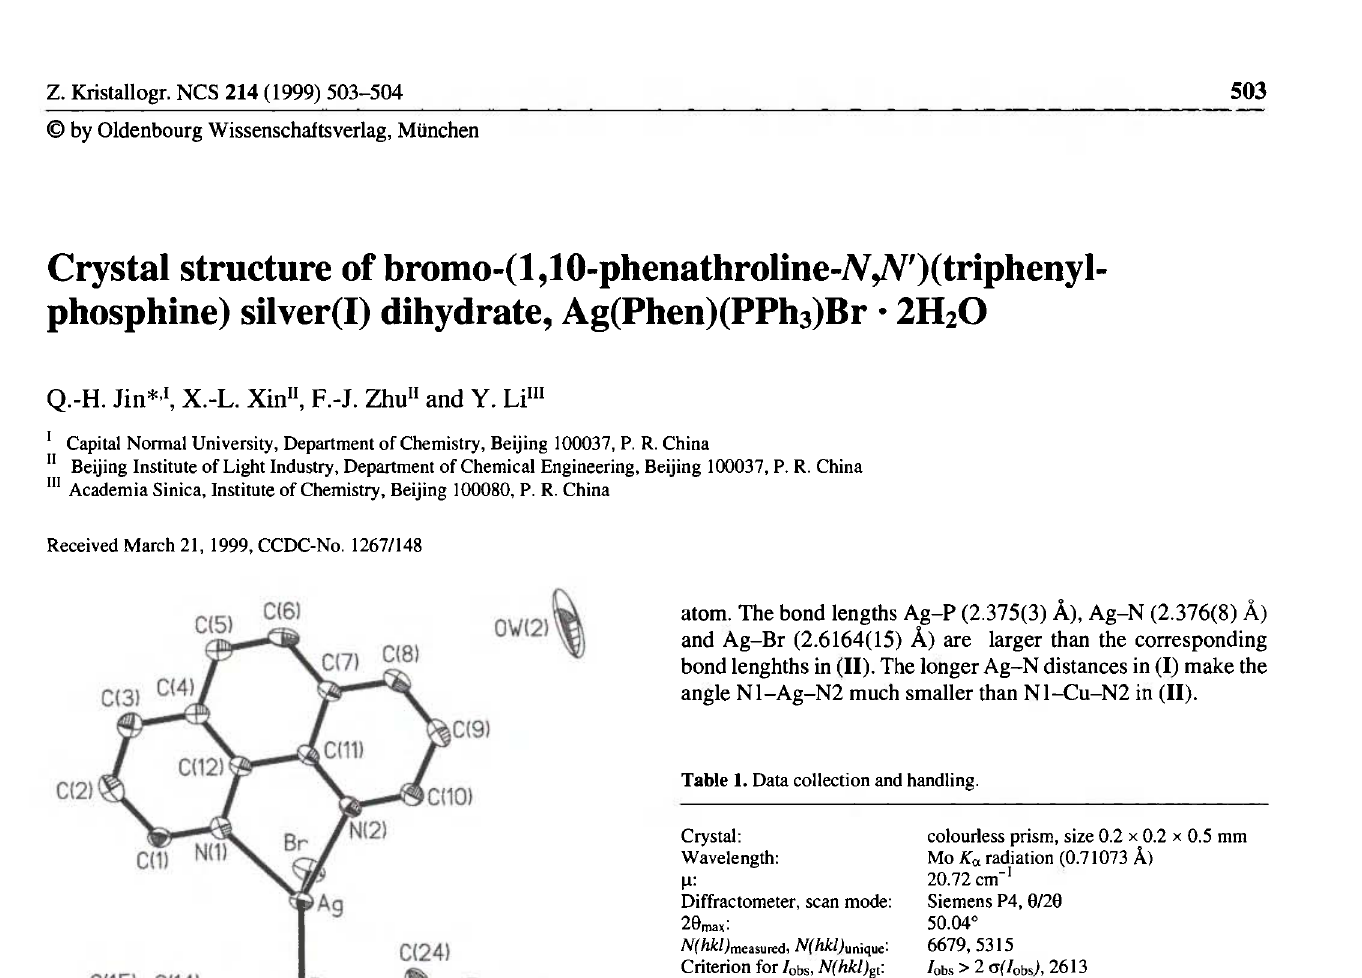
Table 2. Atomic coordinates and displacement parameters (in Ä 2